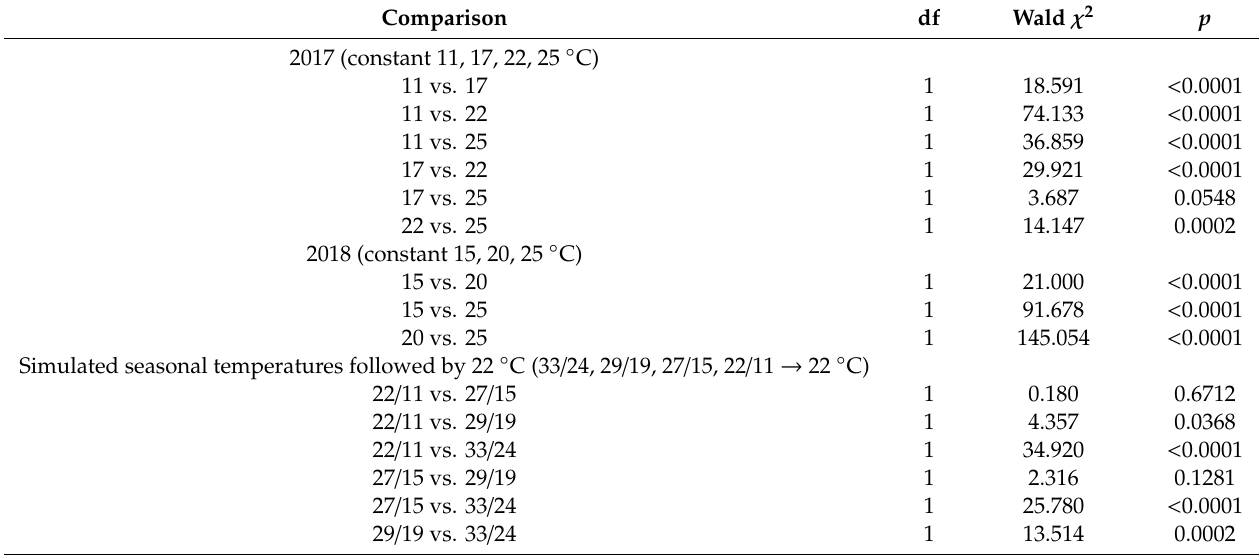
Table 3. Linear contrasts comparing the slope coe ffi cients for Linum arenicola seed germination following exposure to constant or simulated seasonal temperatures. Alternating temperatures simulate the average daily maxima and minima for the winter (22 / 11 ◦ C), early spring or late autumn (27 / 15 ◦ C), early autumn or late spring (29 / 19 ◦ C), or summer (33 / 24 ◦ C) throughout